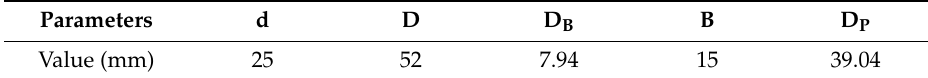
Table 1. Bearing size at the drive end (unit: mm) [43].